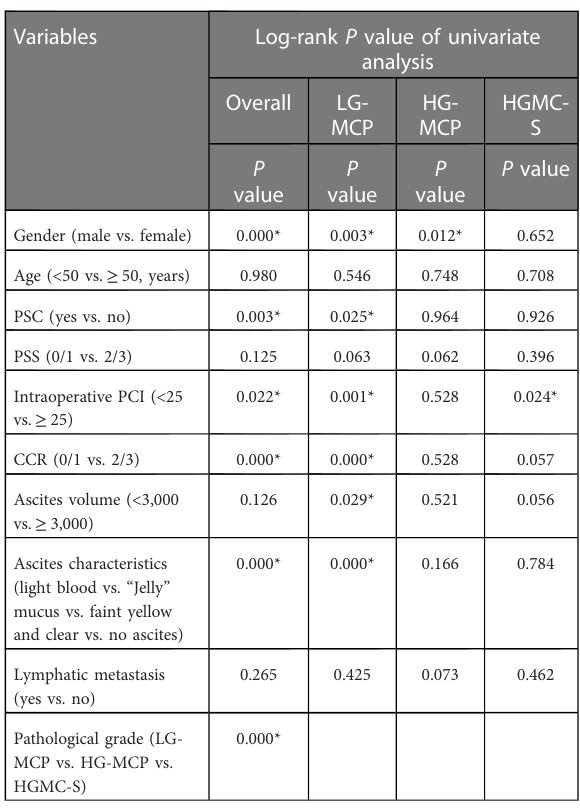
TABLE 2 Univariate analysis affecting overall survival after CRS.